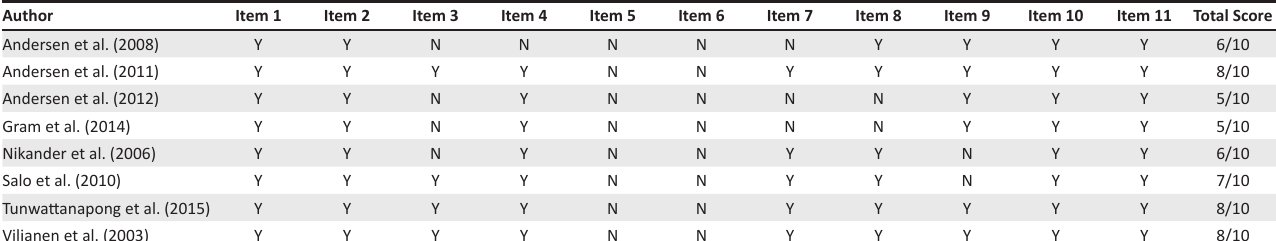
TABLE 1: Scores according to Physiotherapy Evidence Database criteria.